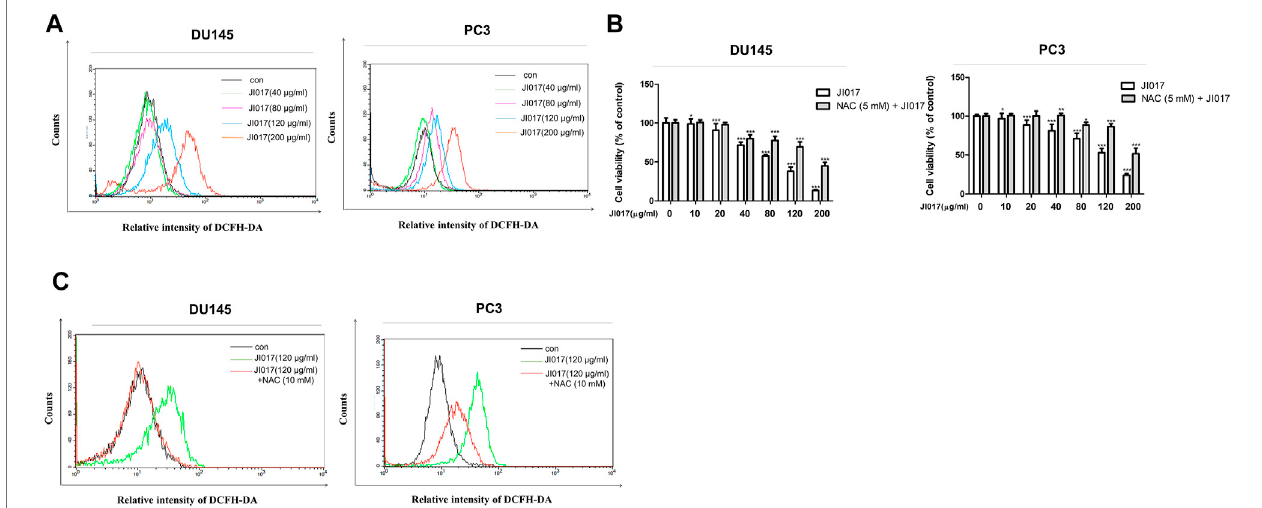
FIGURE 4 | JI017 treatment induced ROS accumulation in prostate cancer cells. Intracellular ROS levels in DU145 and PC3 cells treated with JI017 (40, 80, 120, and 200 μ g/ml) for 24 h were determined by fl ow cytometry. Cells were labeled with DCFH-DA (10 μ M) for 0.5 h (A) . Pretreatment with NAC (10 mM) for 1 h was followedbytreatmentwithvariousconcentrationsofJI017.CellviabilitywasmeasuredusingtheMTSassay (B) .ThelevelsofROSweremeasuredby fl owcytometry (C) . The data are presented as the mean ± SEM. * p < 0.05, ** p < 0.01, and *** p < 0.001 compared to untreated